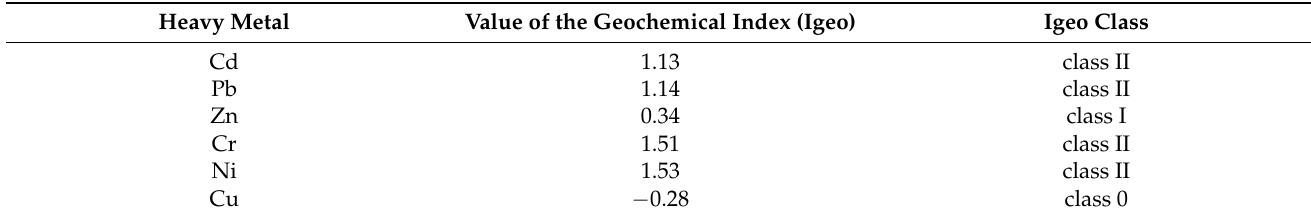
Table 9. The geochemical index (Igeo) of sediment samples.